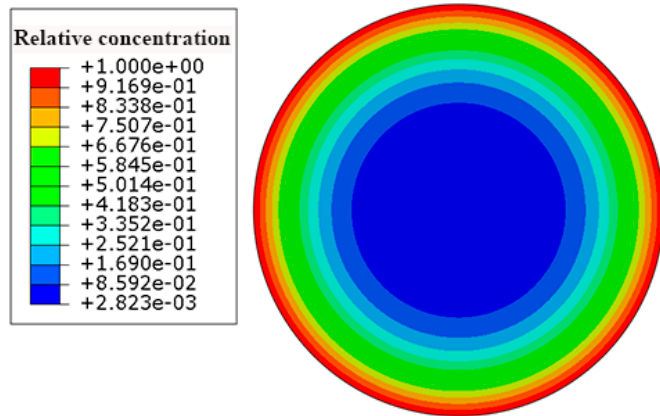
Figure 6. The distribution of the concentration of the water in the HFRP bars.